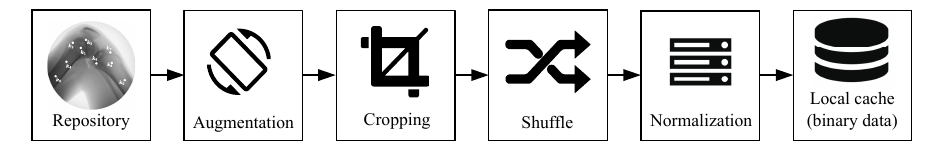
Figure 6. Generation of CNN learning